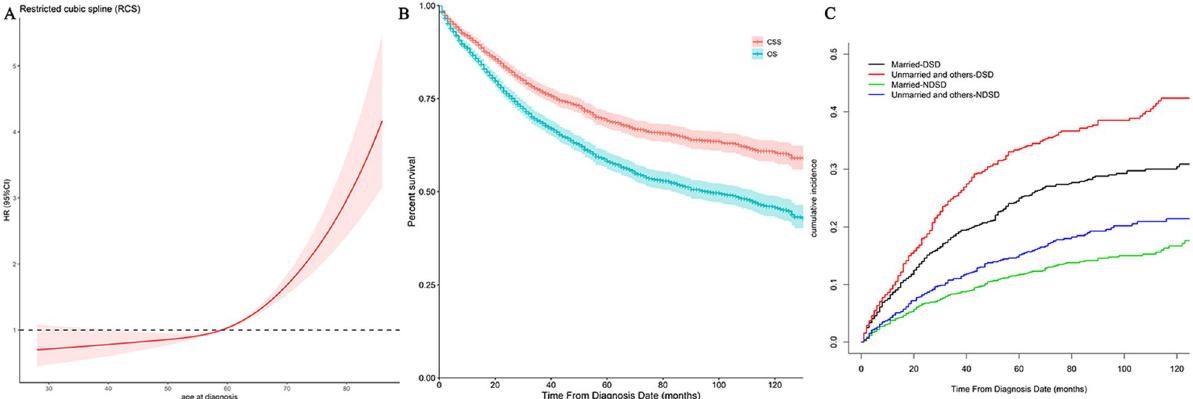
Figure 2. ( A ) A restricted cubic spline (RCS) demonstrated that 59 years old was a reasonable cutoff point. ( B ) OS and CSS of stage Ia HCC patients. ( C ) The cumulative risk curves according to marital